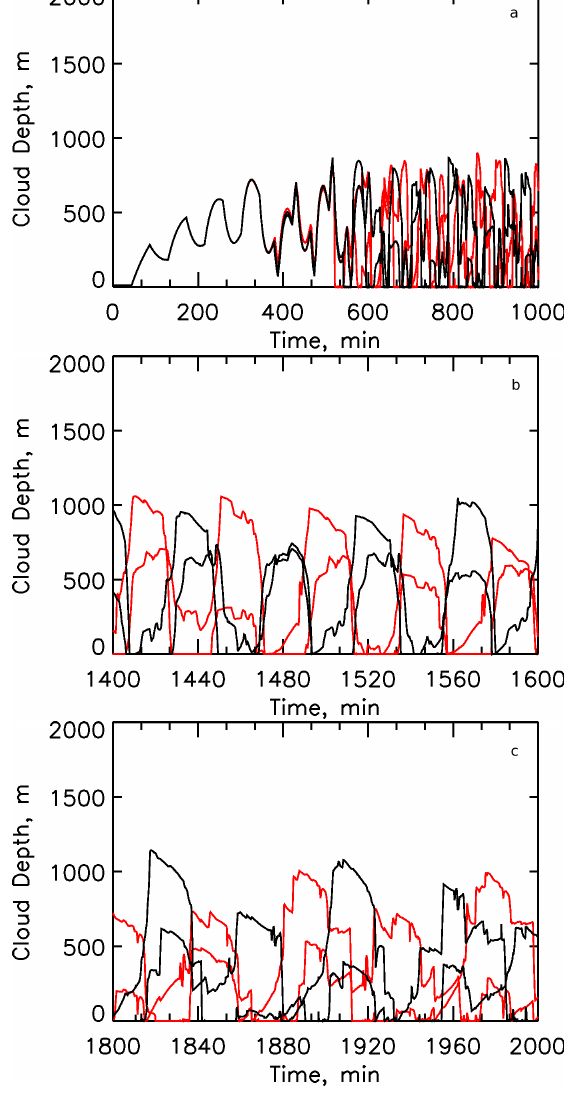
Fig.7. AsinFig.6,butfor reduced to-0.621. (a)0 < t < 1000 min;priorto (cid:100) Fig. 7. As in Fig. 6, but for | η | reduced to − 0.621. (a) 0 < t < | | (b) 1400 < t < 1600 min, adjacent oscillators prefer to be out of phase; (c) 1800 < t < 2000 min, a return to incoherent oscillations. 1000min; prior to ∼ 400min oscillators are in phase but after that are incoherent; (b) 1400 < t < 1600min, adjacent oscillators prefer to be out of phase; (c) 1800 < t < 2000min, a return to incoherent